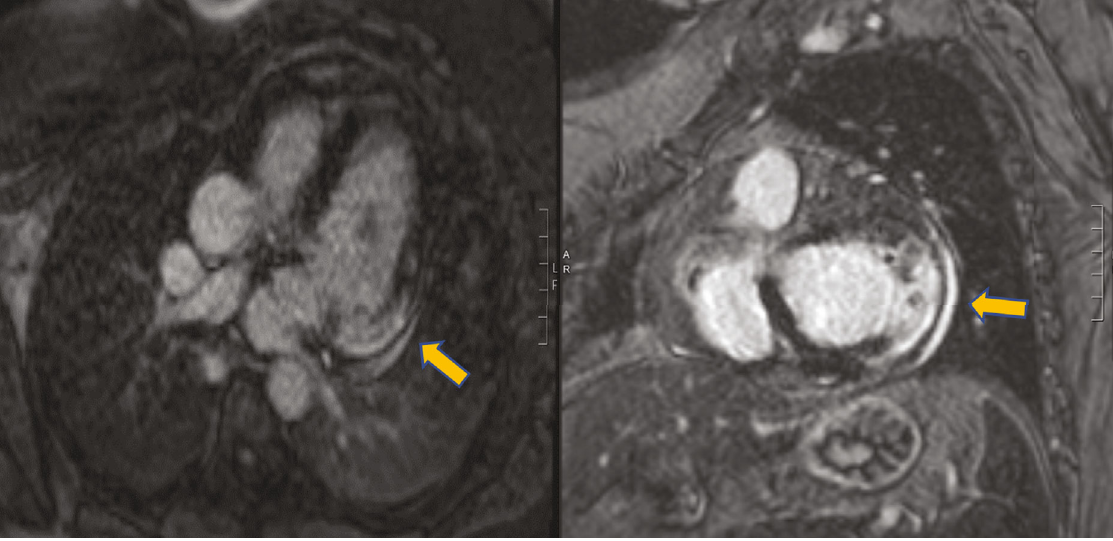
Figure 4: Cardiac magnetic resonance imaging (MRI) showing transmural late gadolinium enhancement in the basal lateral wall (yellow arrows) which is highly concerning of Chagas